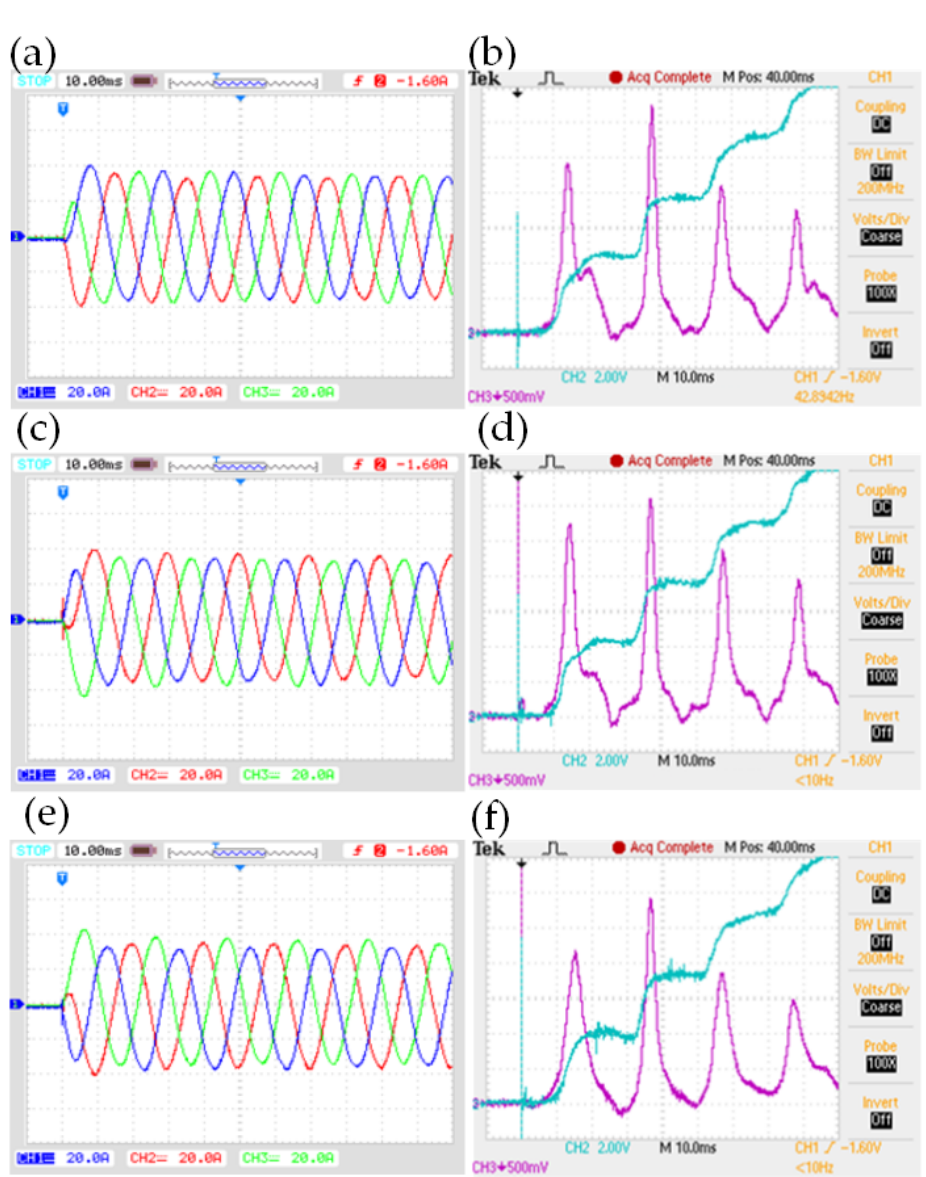
Figure 19. Waveforms of physical quantities during the classic direct starting of an electromechanical system with the use of a vacuum circuit breaker, where: ( a , c , e ) concerns the stator winding currents ( i A —CH1, i B —CH2, i C —CH3: scale 20 A/div), ( b , d , f ) concerns the torque on the shaft ( T —CH3: scale 50 Nm/1V) and the rotor speed of the motor ( n —CH2: scale 15